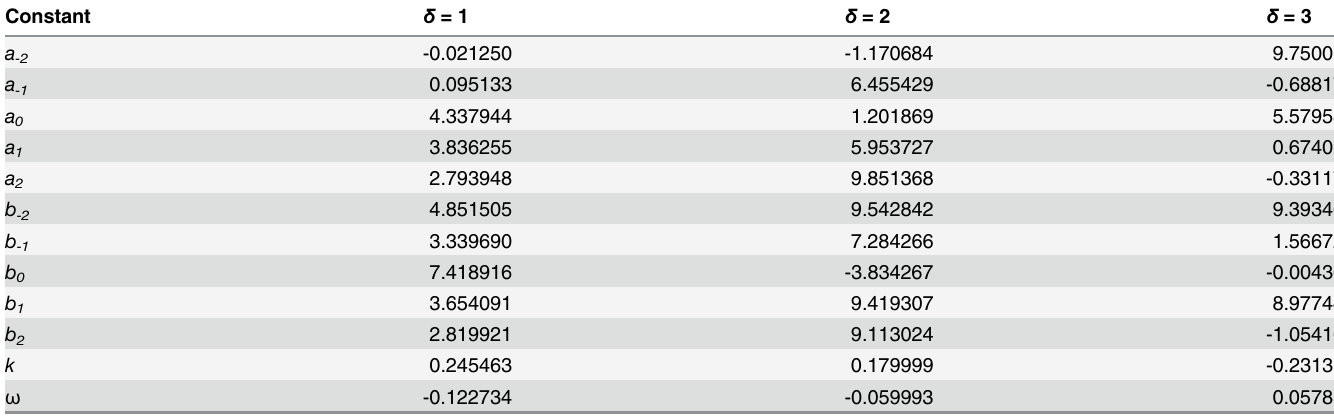
Table 9. Optimal values of unknown constants acquired by GA for example 2 for different values of δ .